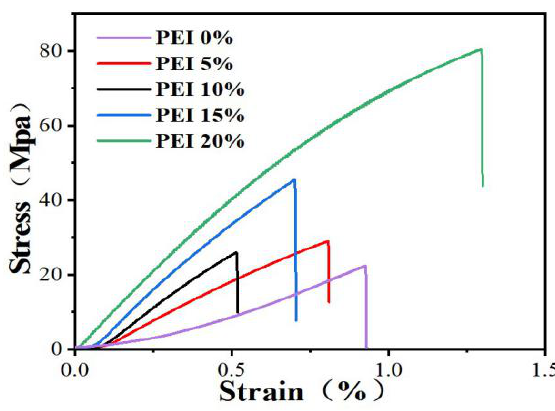
Figure 3. Tensile properties of the composite films. Table 1. The results of tensile tests of the composite films.